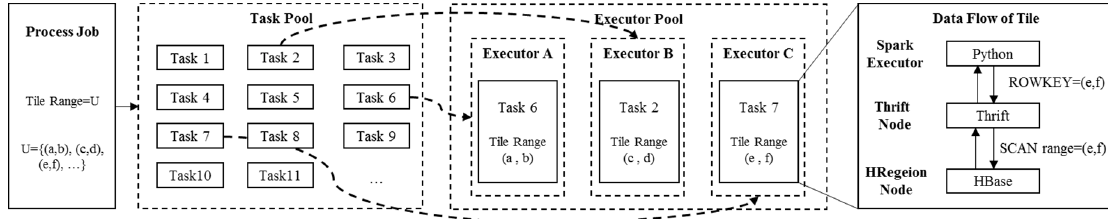
Figure 6. Data flow between HBase and Spark.